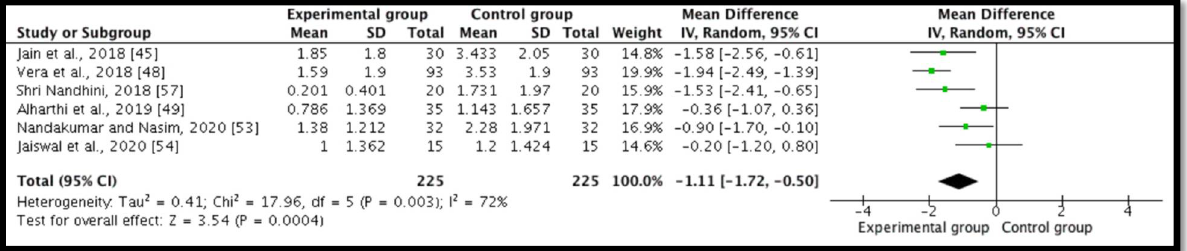
Figure 3. Forest plot comparing postoperative pain between the experimental group (intracanal cryotherapy) and the control group (room temperature) at 6 h. IV: Intravitreal.